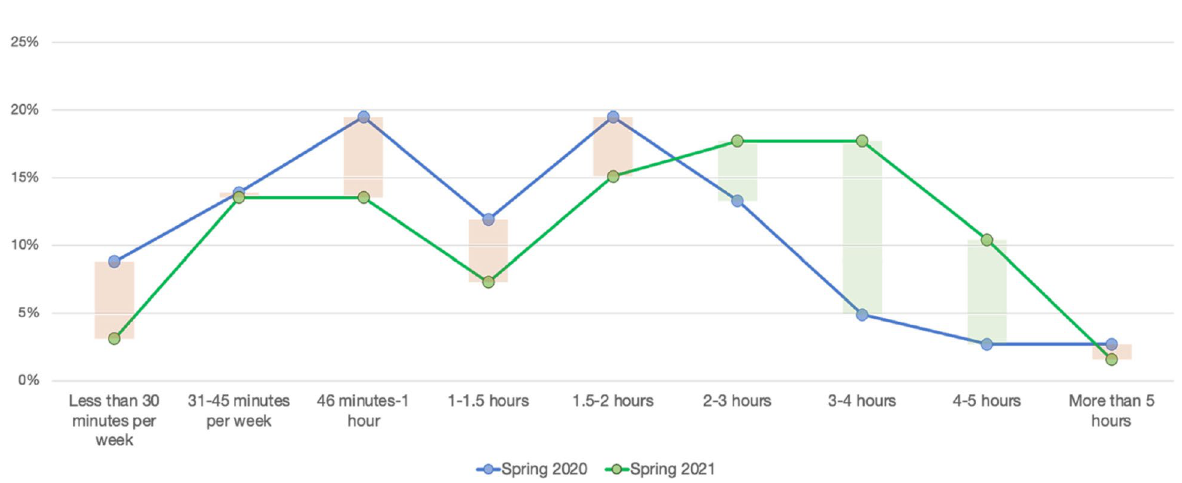
Fig. 2 Time Planned for Science: Spring 2020 vs. Spring